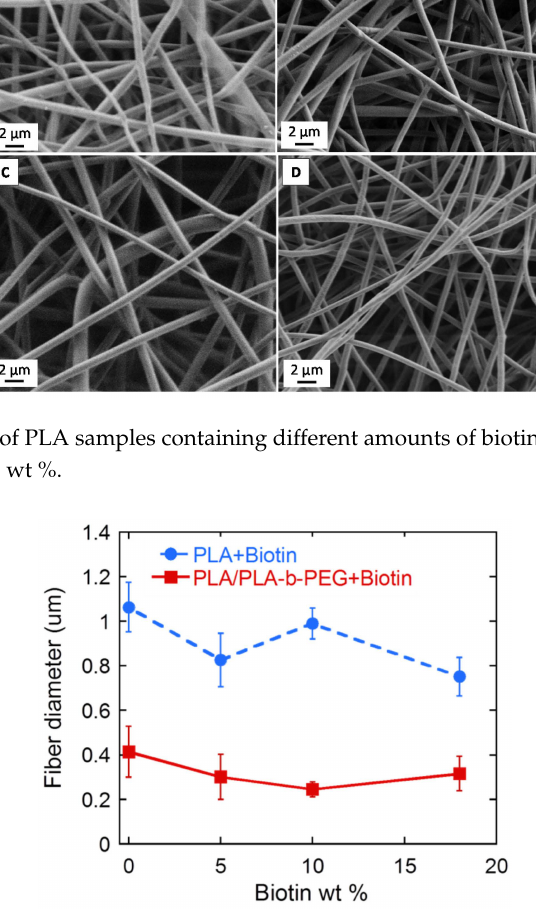
Figure 2. Average fiber diameter of PLA and PLA/PLA- b -PEG samples containing different amounts of biotin.